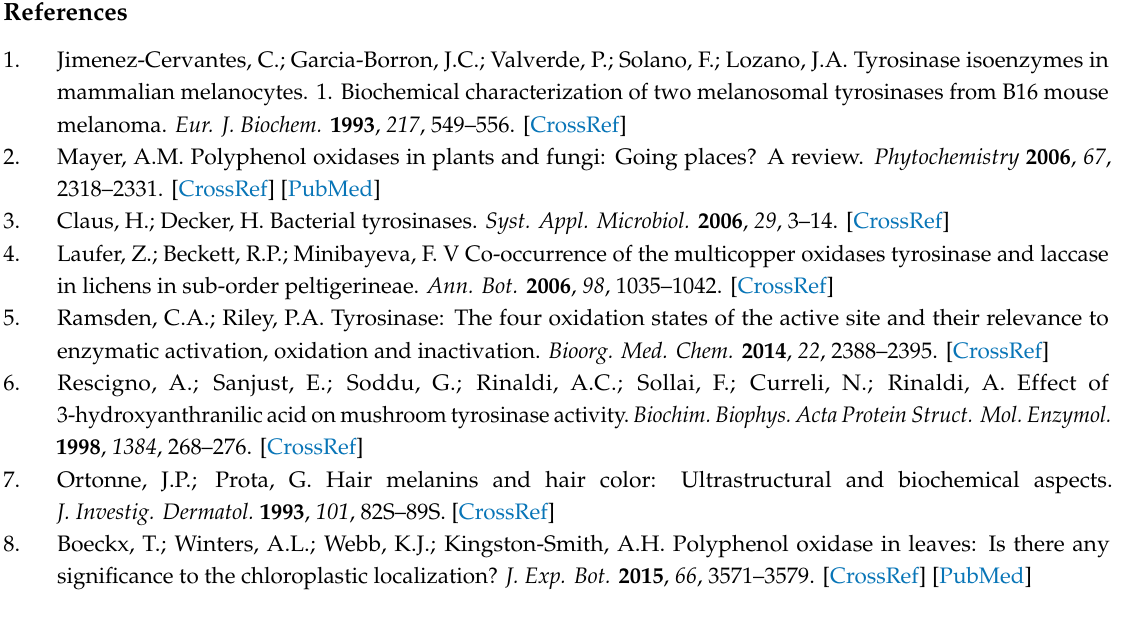
Figure S1: Electrophoretic separation on 6% polyacrylamide gel of the PCR product obtained for the polyubiquitin gene (line 1); Table S1: Combination of primers sense and antisense used in PCR reactions and size of the expected fragments given in base pairs (bp); Figure S2: Polyubiquitin sequencing